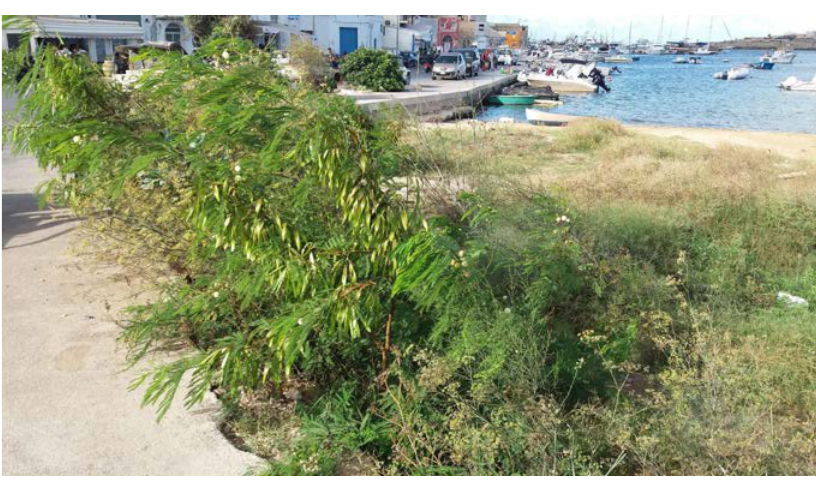
Figure 3. Naturalized young Leucaena individual growing at the Port of